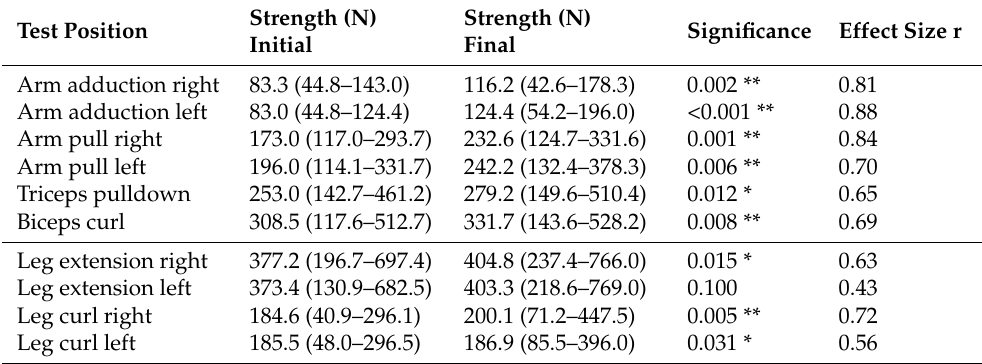
Table 2. Initial and final median maximum strength values (ranges) of the upper body group (UBG).